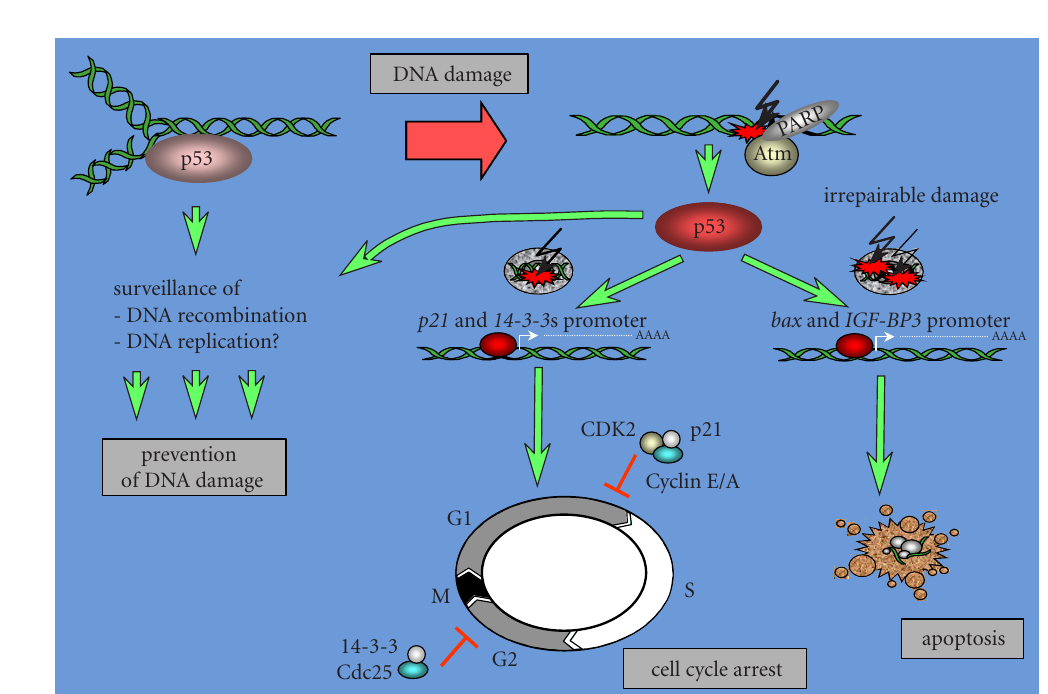
Figure 1: Maintenance of the genomic stability by multiple functions of p53. p53 surveils the genomic integrity via a hierarchy of different functions both during proliferation-associated processes and during cellular stress situations. crease in sister chromatid exchanges after UV in cells from p53 / mice rather than differences in excision repair [28]. The latter observation might point towards a role of p53 in UV- irradiation induced DNA exchange events, since recombina- tion is frequently coupled to DNA synthesis in order to allow the removal of unrepaired lesions, such as unexcised photo-